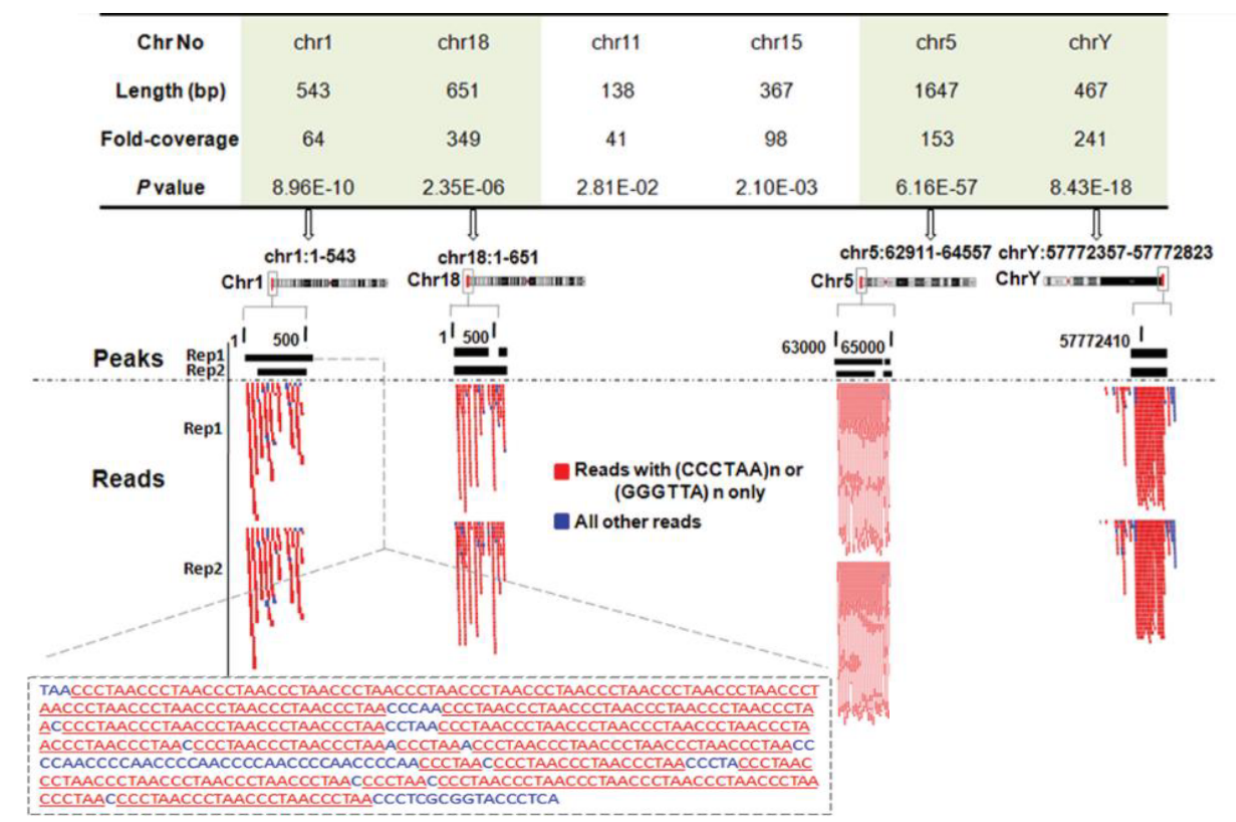
Figure 1. NM23-H2 ChIP-seq reads are enriched for TTAGGG or CCCTAA repeats from the telomeres. Reproduced with permission from Kar et al., 2012 NAR